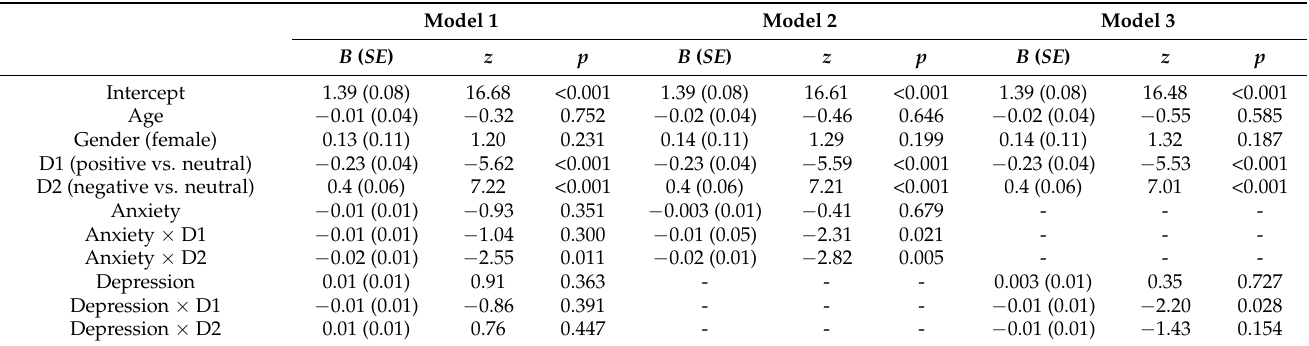
Table 2. Results of GLMMs with anxiety and depressive symptoms as predictors of WM updating